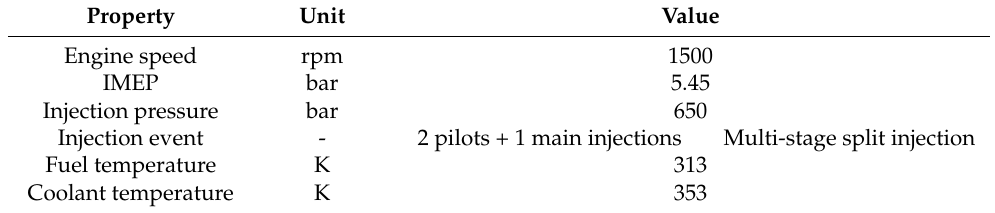
Table 3. Experimental conditions for engine experiments; IMEP: indicated mean effective pressure.